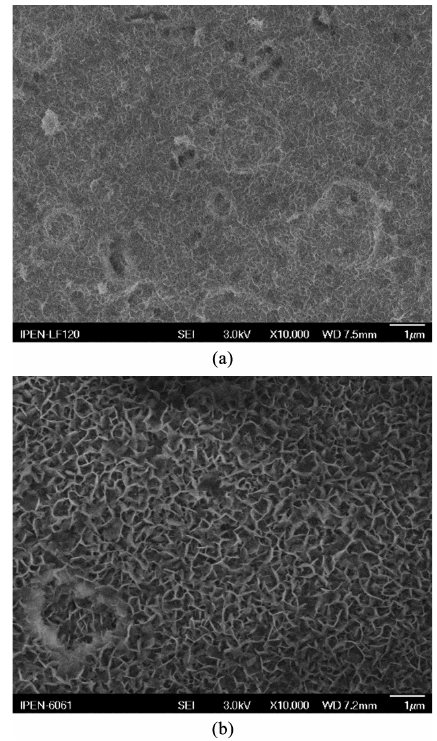
Figure 3. Scanning electron micrographs revealing HTC formation within pits and crevices: (a) LT-HTC; (b)